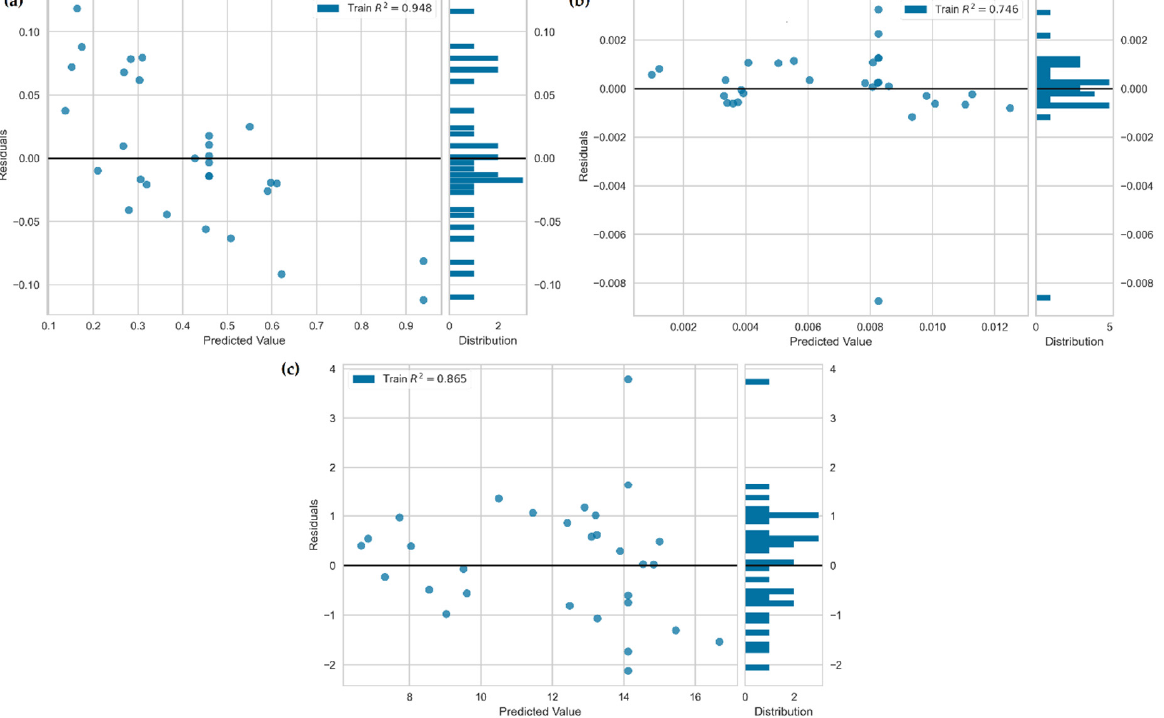
Figure 6. Experimental versus AdaBoost regression predicted ( a ) MRR ( b ) EWR ( c ) SR. 3.2. Case Study 2: WEDM of Metal Matrix Composite 3.2.1. Experimental Background An experimental dataset based on WEDM machining of metal matrix composite, re- ported by Shandilya et al. [32], is considered in this case study. The design of experimen- tation of Shandilya et al. [32] is based on Box–Behnken design. WEDM machining was carried out for a rectangular, Al-6061-based metal matrix composite workpiece having a thickness of 6 mm. The input parameters for the machining were voltage, pulse-on time, pulse-off time and wire feed rate to determine the effect on MRR and Kerf. Kerf was meas- ured through a microscope and MRR was calculated by 𝑀𝑅𝑅 = 𝑀 (cid:3033) − 𝑀 (cid:3036) 𝜌𝑡 (8) where 𝑀 (cid:3033) and 𝑀 (cid:3036) are the mass of material after and before machining, 𝜌 is the density of workpiece and 𝑡 is the total time of machining.